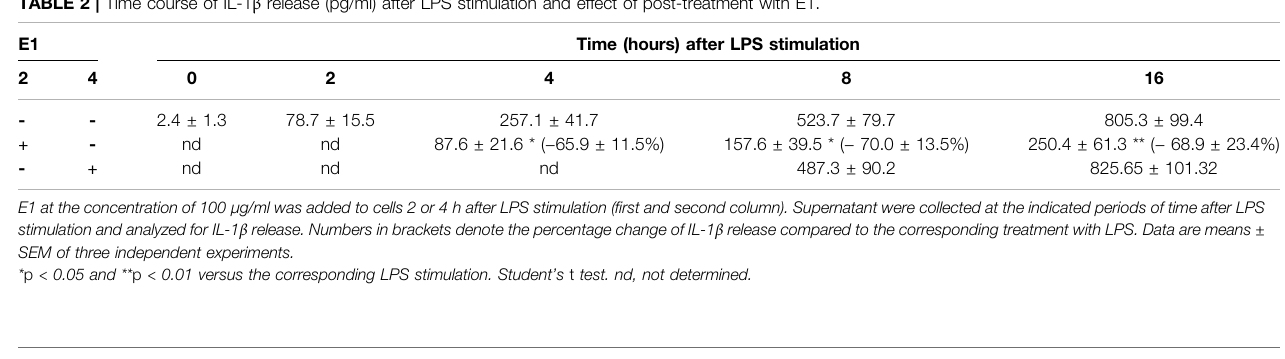
Frontiers in Pharmacology |